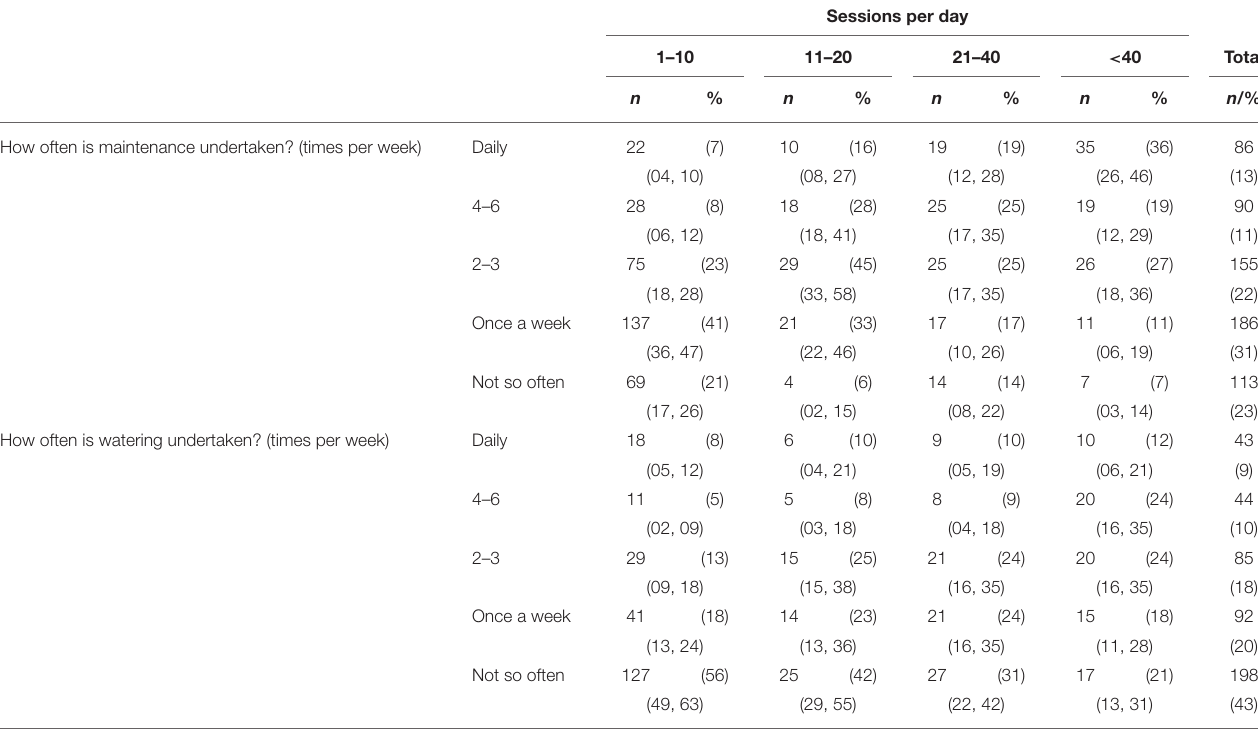
TABLE 6 | Combined maintenance regimes contrasted to usage frequency and the frequency of watering contrasted to usage